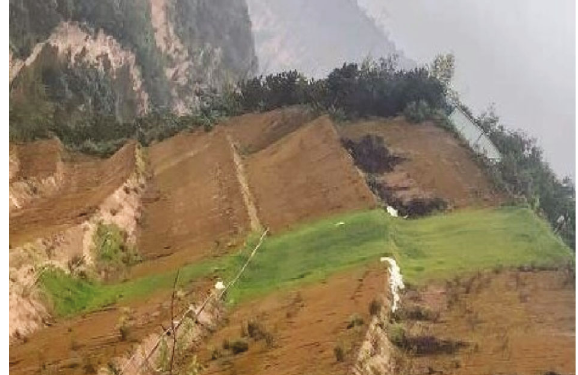
Figure 15: Vegetated slope protection.